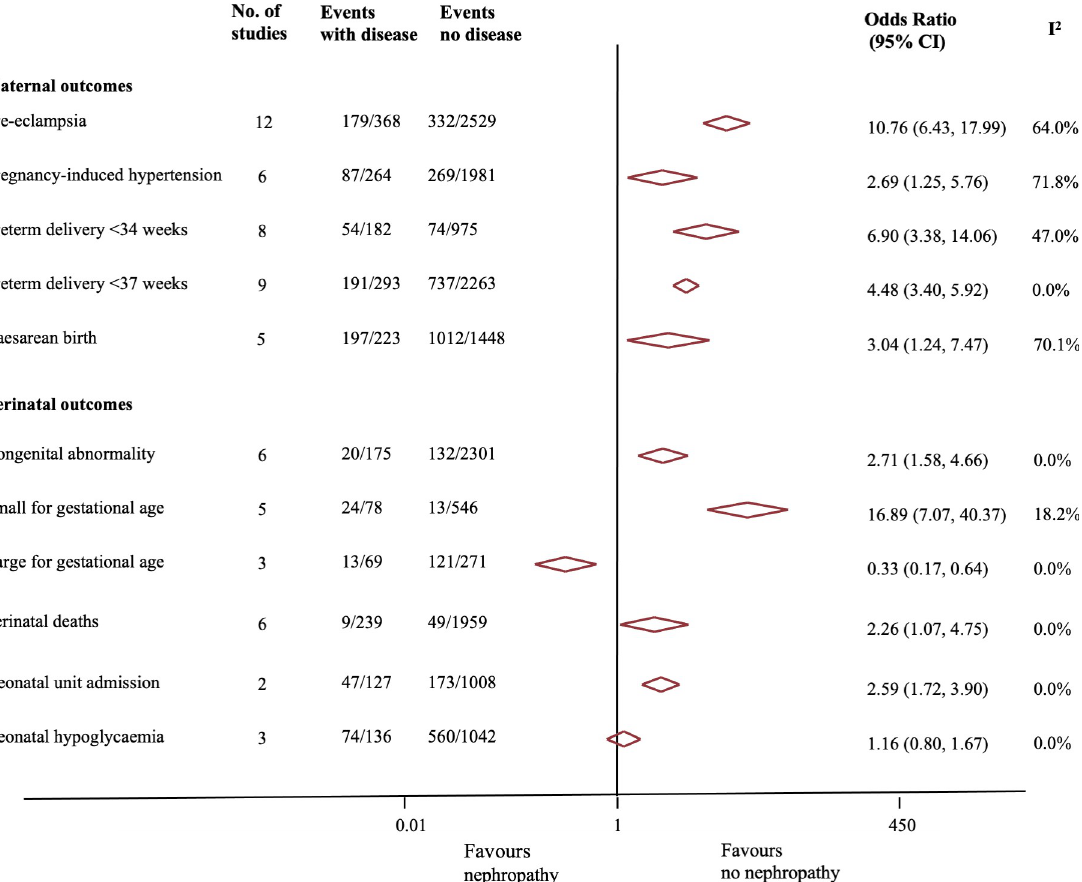
PLOS Medicine| https://doi.org/10.1371/journal.pmed.1003856 November22,